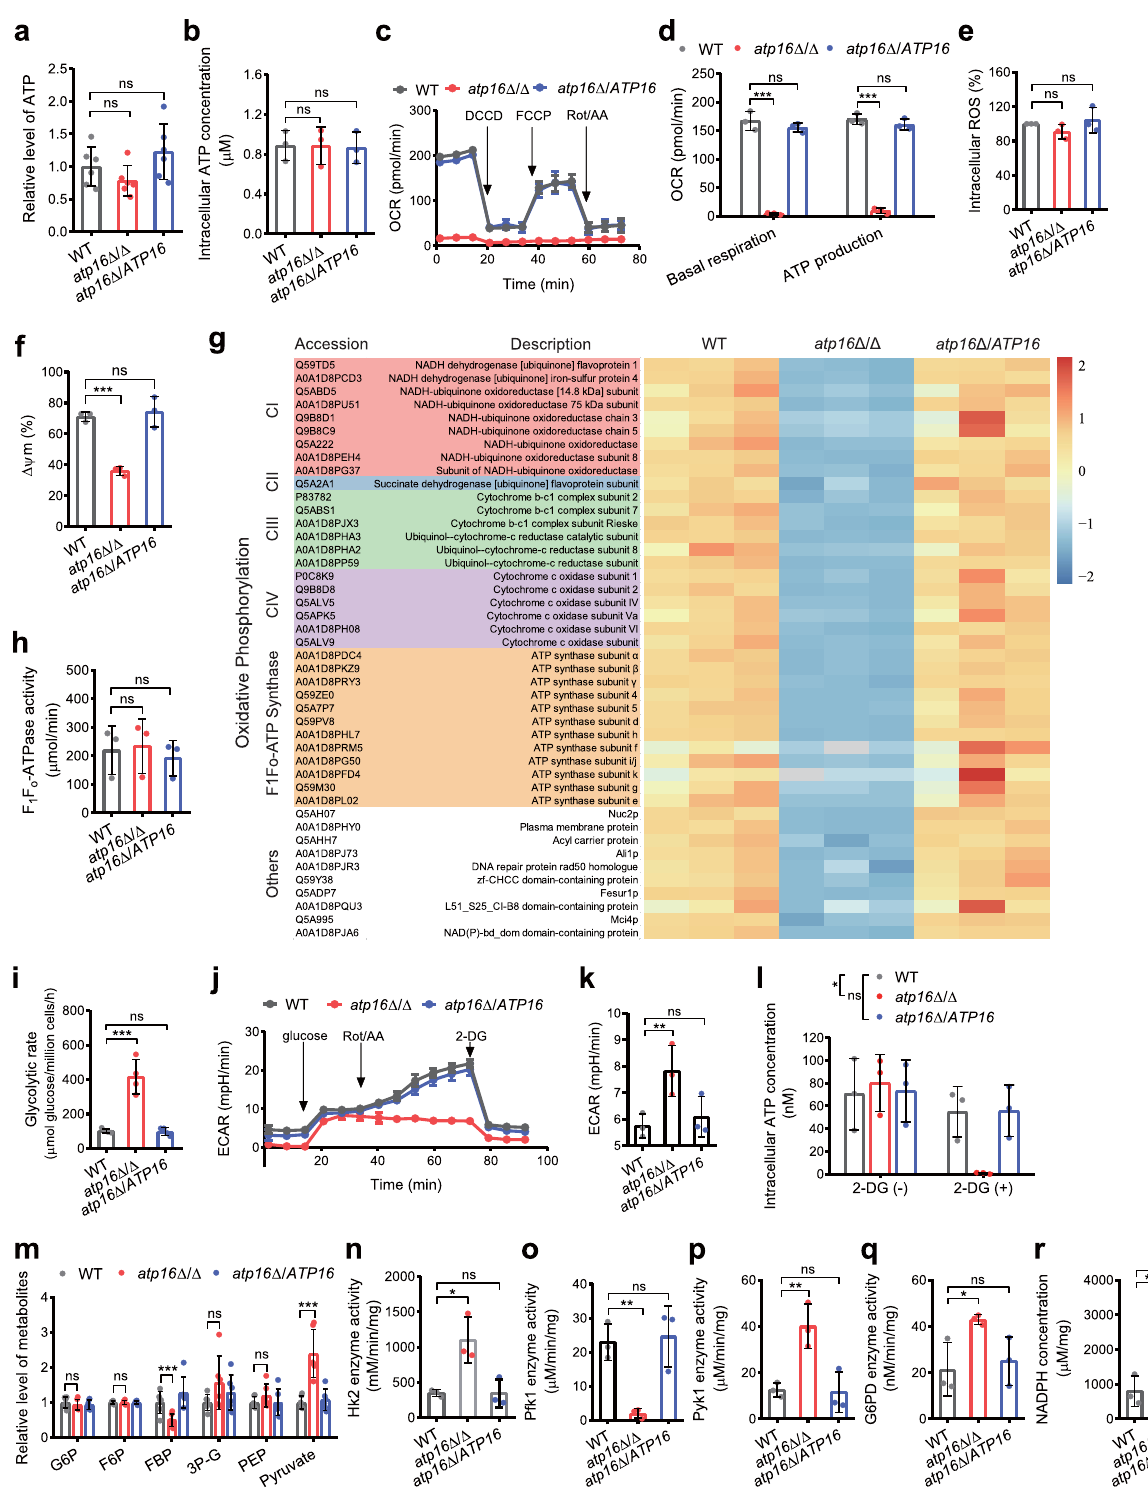
regulates mitochondrial OXPHOS DNA transcription and protein expression, and affects F 1 F o -ATP synthase proton channel assembly and dimer